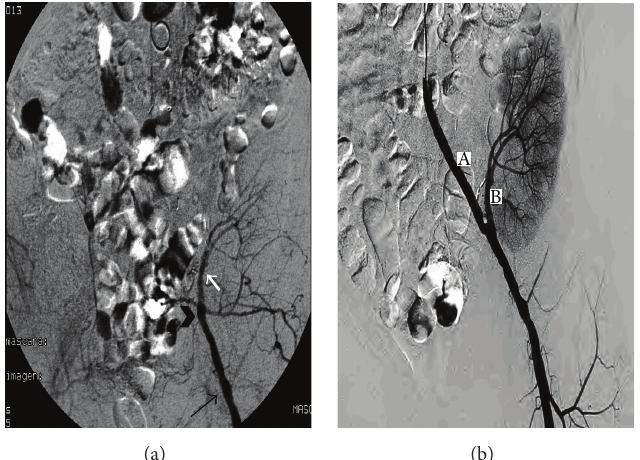
Figure 2: (a) Recanalization of both the distal branch of the left ABFB (head arrow) and renal artery of the graft (white arrow) and femoral common artery (black arrow). (b) Angiographic control showing both patency of the left arm of the ABFB (A) and the artery of kidney graft